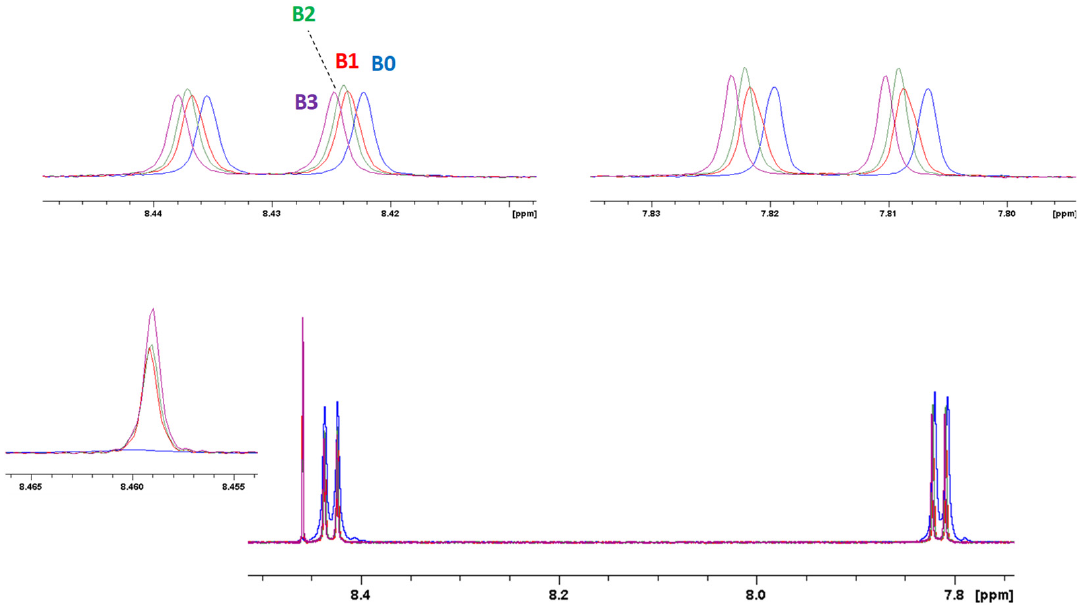
Figure 9. Concentration ‐ dependent 1 H NMR spectra of PTAS at different Pb 2+ ion ratios in D 2 O, 298 K. B0: 30 μ M PTAS solution; B1: 30 μ M PTAS and 1 μ M Pb 2+ solution; B2: 30 μ M PTAS and 2 μ M Pb 2+ solution; B3: 30 μ M PTAS and 5 μ M Pb 2+ solution.